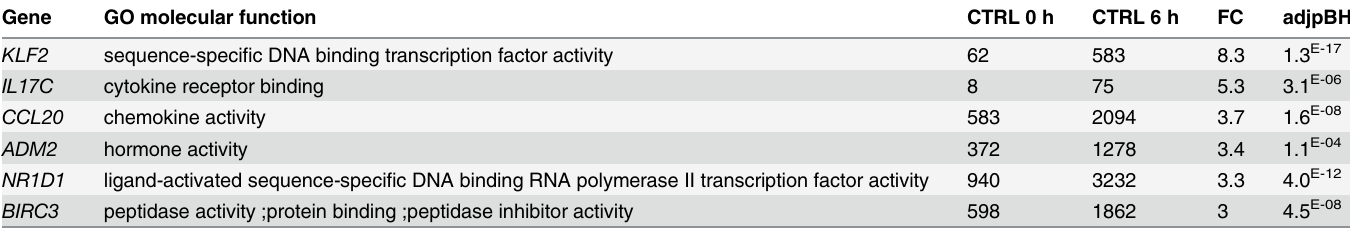
Table 1. List of genes in the protein-binding gene-ontology category that were most upregulated (FC (cid:3) 3) in CTRL cells 6 hours after P . aeruginosa infection. Gene GO molecular